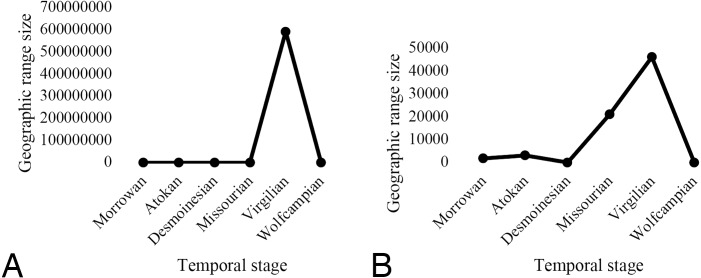
Mean geographic range size in km2 of cephalopods through time.Nautiloid species (A) and ammonoid species (B) range changes occur but are not statistically significant when analyzed using non-parametric tests (note, median range size data not graphed but for all cephalopods they are 79 km2 for all time intervals, for ammonoids they are 78.5 km2 for the Desmoinesian and Wolfcampian and 79 km2 for all other time intervals, and for nautiloids they are 79 km2 for all time intervals) or when log transformed data are analyzed using parametric tests (note log transformed data not graphed but mean transformed values for all cephalopods are 5.51 [standard error 0.75] for the Morrowan, 4.05 [standard error 1.02] for the Atokan, 4.36 [standard error 0.49] for the Desmoinesian, 5.65 [standard error 0.49] for the Missourian, 5.96 [standard error 0.79] for the Virgilian, and 4.31 [standard error 0.52] for the Wolfcampian).